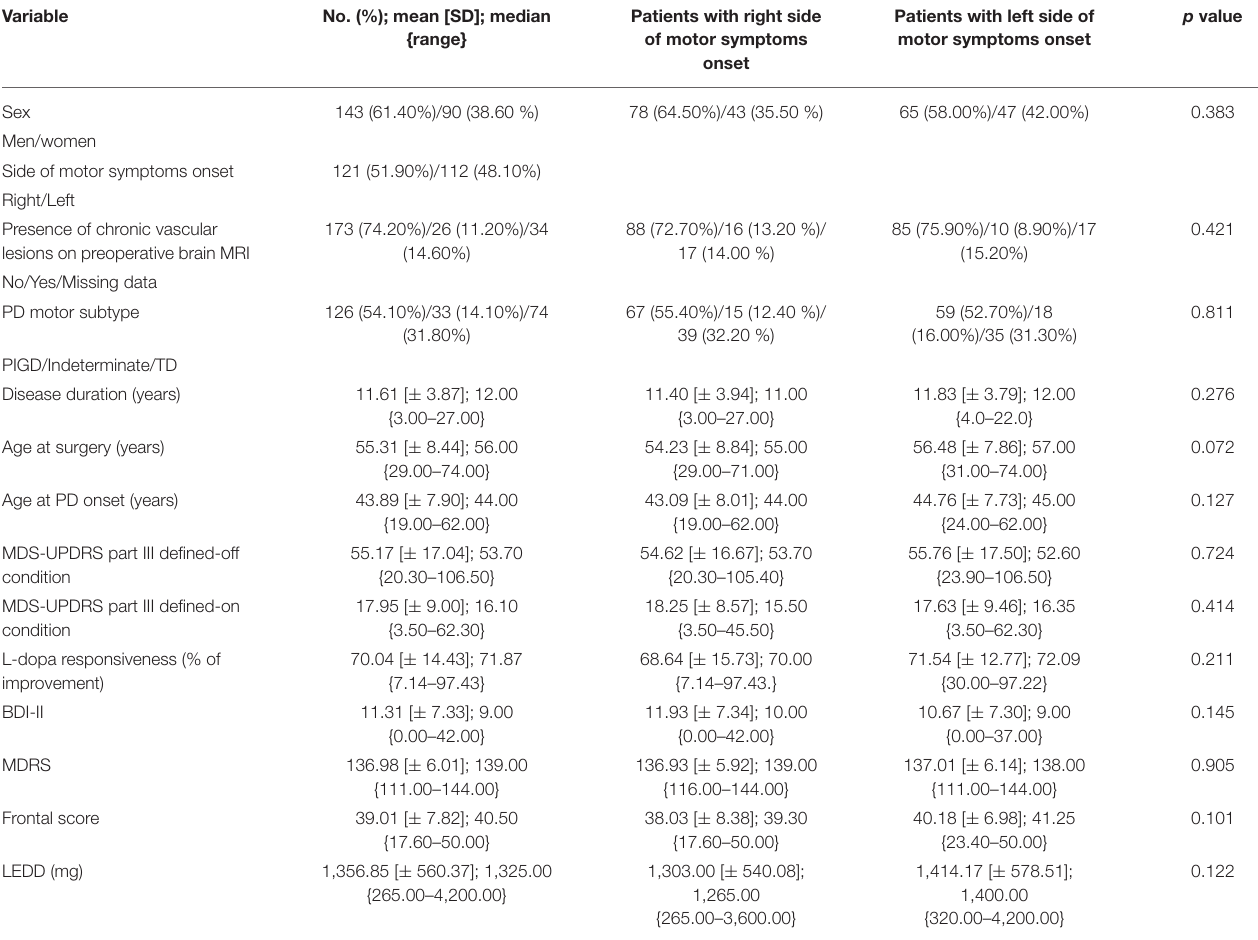
TABLE 1 | Demographic and clinical characteristics of the PD patients included in the analysis ( n = 233). Variable